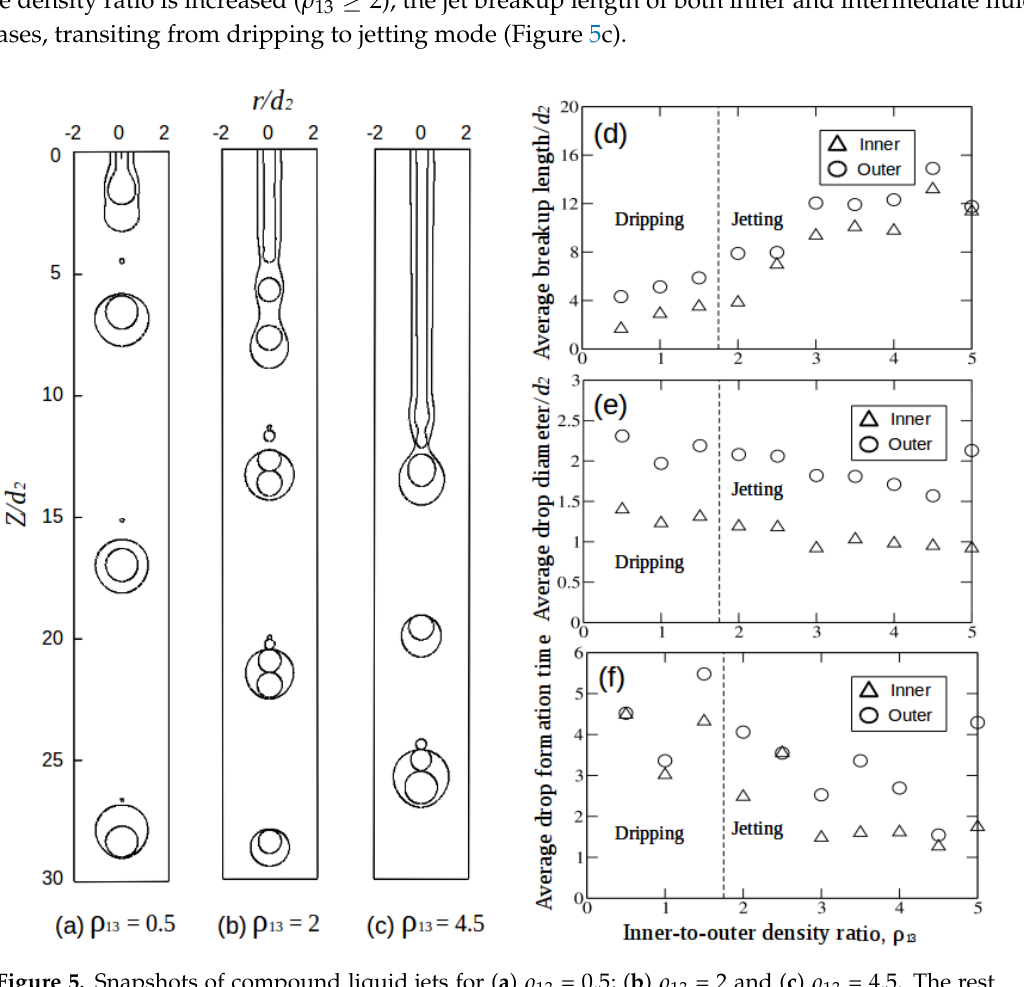
Figure 5. Snapshots of compound liquid jets for ( a ) ρ 13 = 0.5; ( b ) ρ 13 = 2 and ( c ) ρ 13 = 4.5. The rest of the parameters are ρ 23 = 1, µ 13 = 1, µ 23 = 1, Re = 37.5 and We = 1.5. Graphs ( d – f ) represents the average breakup length, drop diameter and drop formation time for variable inner-to-outer density ratios. Readers can refer to Video “S2:Inner-to-outer Density ratio” in the Supplementary Materials for better understanding of the jetting mode and the chaotic drop formation